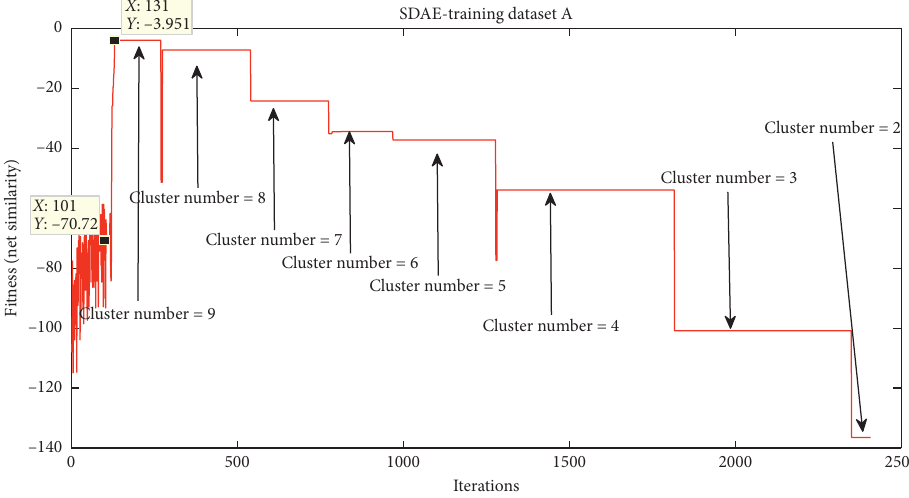
Figure 10: The results of the energy function (similarity) for all samples. Table 2: The results of the Silhouette index with different cluster numbers by using an SAE/SDAE with adAP (the training dataset). Here, “—” means there is no cluster number equal to 10, 11, or 12.